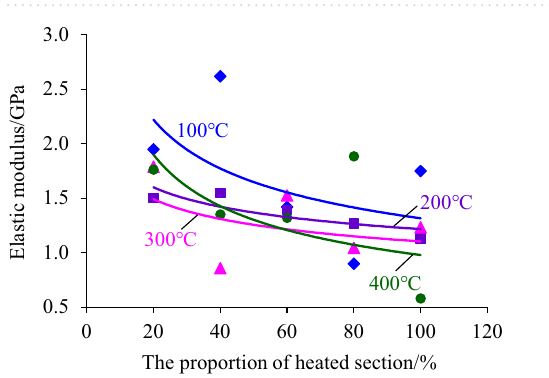
Figure 4. The change rule of the elastic modulus with the heating temperature increasing.